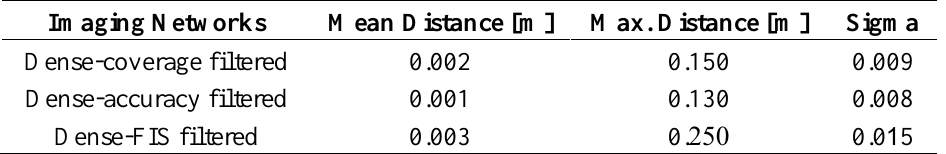
Table 1. The cloud to cloud distance